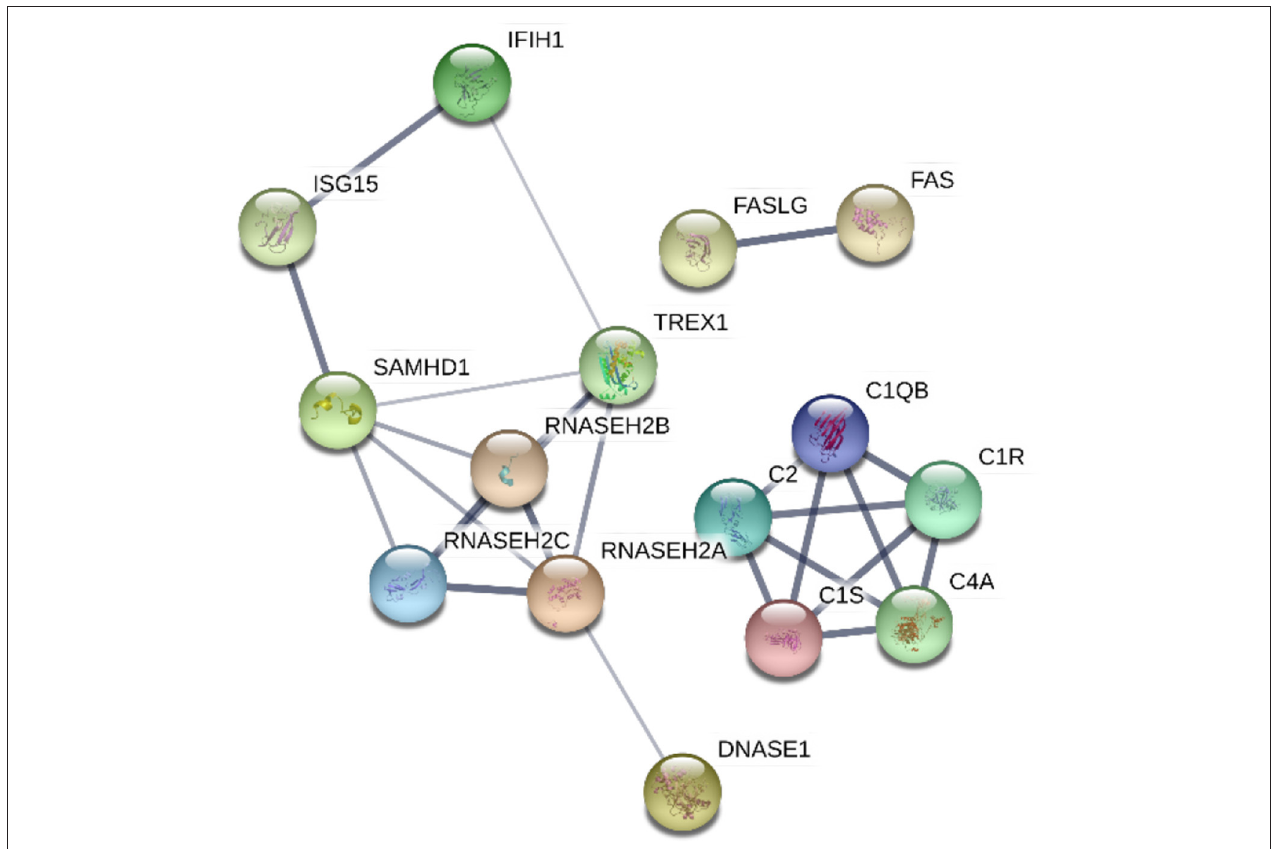
FIGURE 2 | Protein-protein interaction network of proteins encoded by genes found to cause monogenic lupus. The confidence of data supporting these interactions are represented by the thickness of the lines. The analysis was performed using STRING V10.0 (STRING https://string-db.org/).